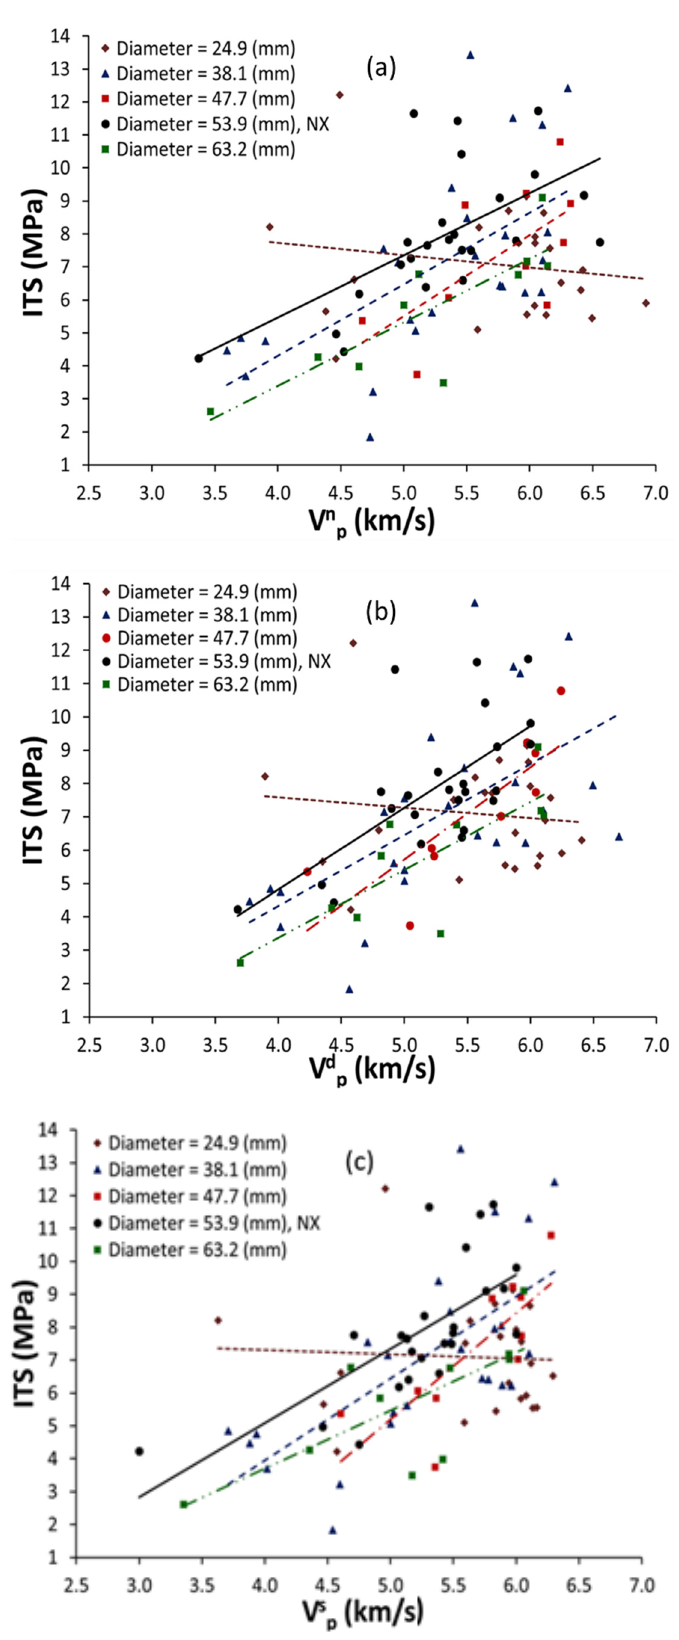
Figure 4. Variation in indirect tensile strength (ITS) values. ITS plotted as a function of ( a ) V np , ( b ) V dp , and ( c ) V sp for different sample diameters.